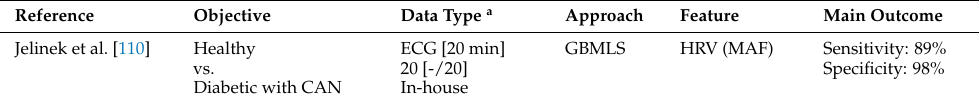
Table 7. Machine learning methods for diabetes